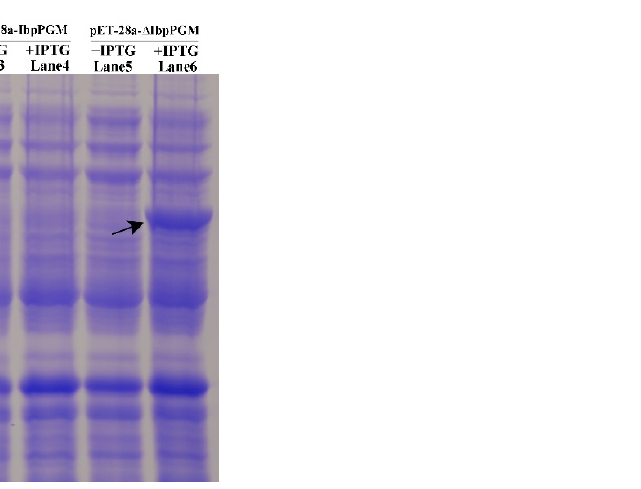
7 of 14 Figure 3. Expression patterns of IbpPGM. ( a ) Expression of IbpPGM in different tissues of Xu 781 sweet potato. L, leaves, S, stems, P, petioles, SR, storage roots, FR, fibrous roots. ( b ) Induced expres- sion of IbpPGM by a 175-mM sucrose treatment. * and ** indicate a significant difference versus 0 h at p < 0.05 and < 0.01, respectively, based on Student’s t -test. 3.3. Expression of IbpPGM in E. coli To investigate whether IbpPGM encodes the mature protein, we constructed a recom- binant vector harboring the full-length ORF of IbpPGM , as well as one carrying the ORF